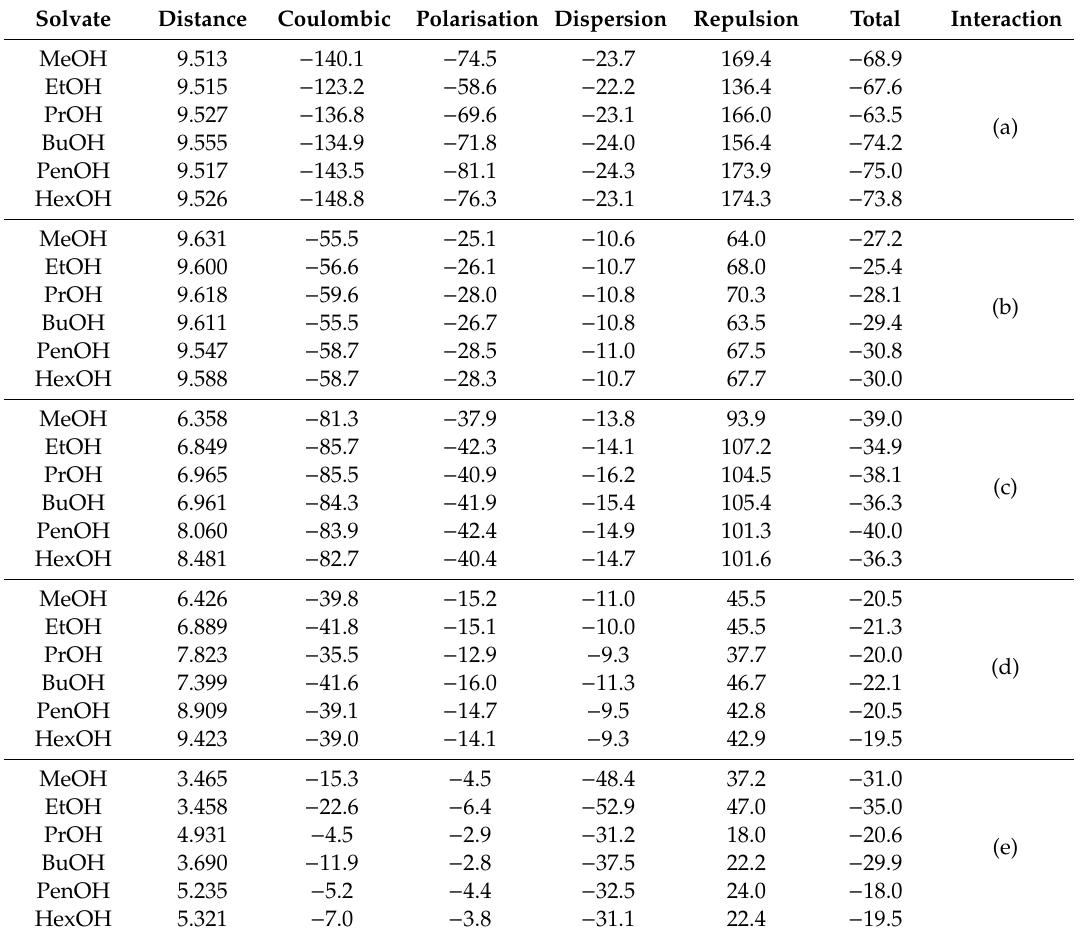
Table 1. The intermolecular energies for each solvate calculated by PIXEL [24–26] and partitioned into di ff erent contributions of coulombic, polarization, dispersion and repulsion. An image of the particular interaction (a-e) is found in Figure 5. Reference structures are methanol [9], propanol (LT form) [8], butanol-hexanol